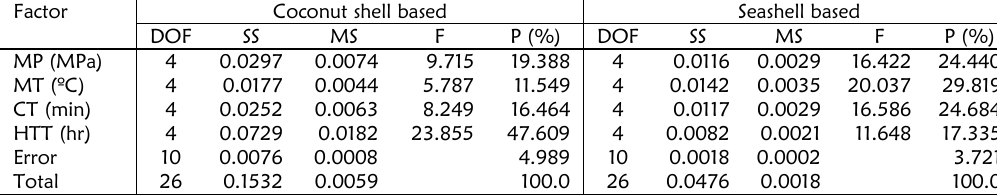
Table 8: ANOVA for Friction Coefficient